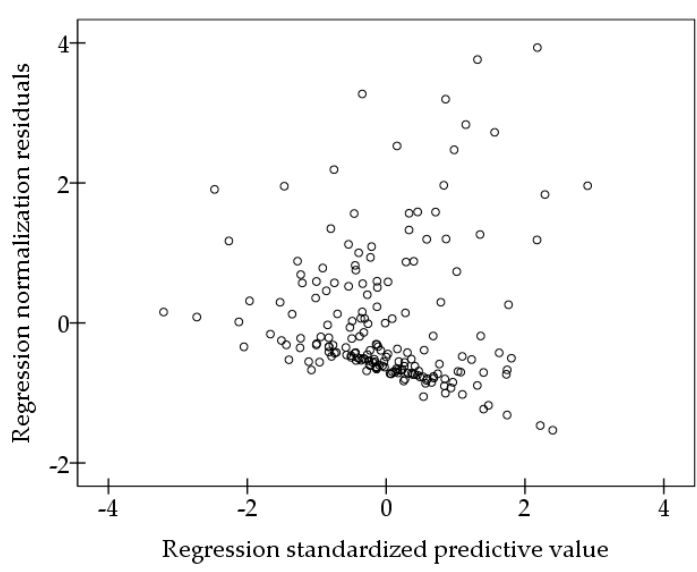
Figure 10. Scatter plot of standardized residual (mean = 0, standard deviation = 0.989, N = 186).